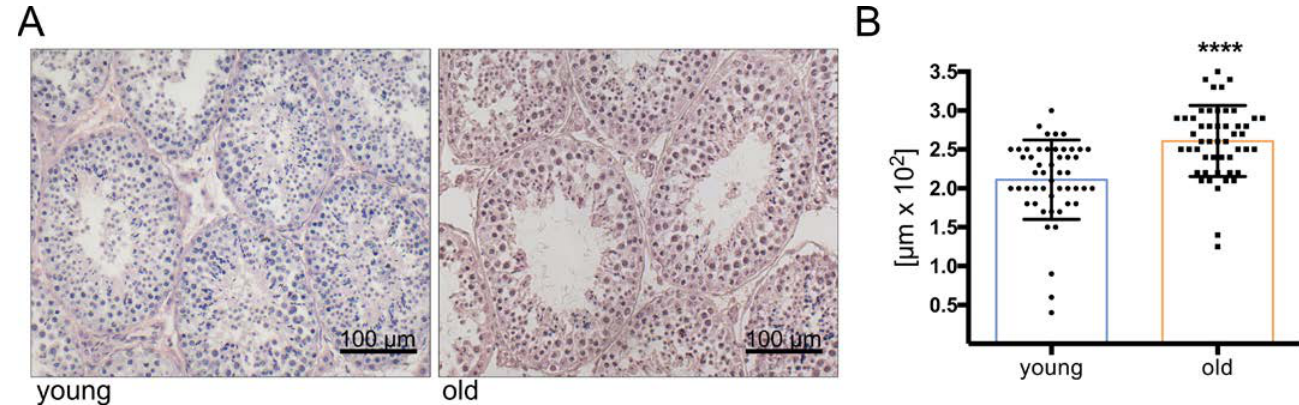
Figure 1. Light micrograph of HE stained sections of testes from young (3 years, left) and old C. jacchus (11 years, right). ( A ) Scale bar indicates 100 µm. Tubular diameters of young (2–3 years, n = 5) and old (10–12 years, n = 4) C. jacchus. ( B ) Tubular diameter was slightly increased in the old C. jacchus (**** p < 0.0001; unpaired t -test); individual diameters are shown, and bars indicate the mean and SD.